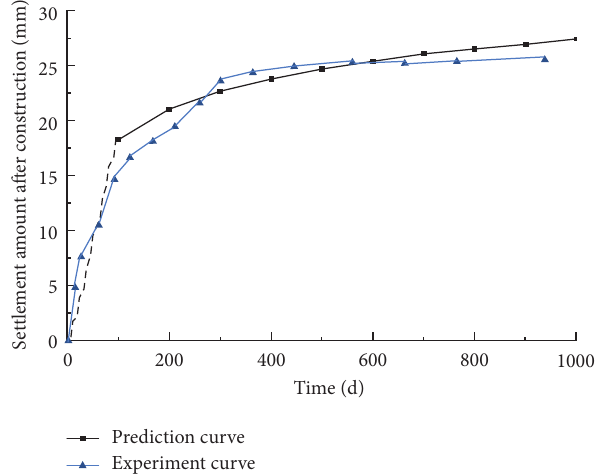
Figure 16: Prediction curve and experiment curve of the test